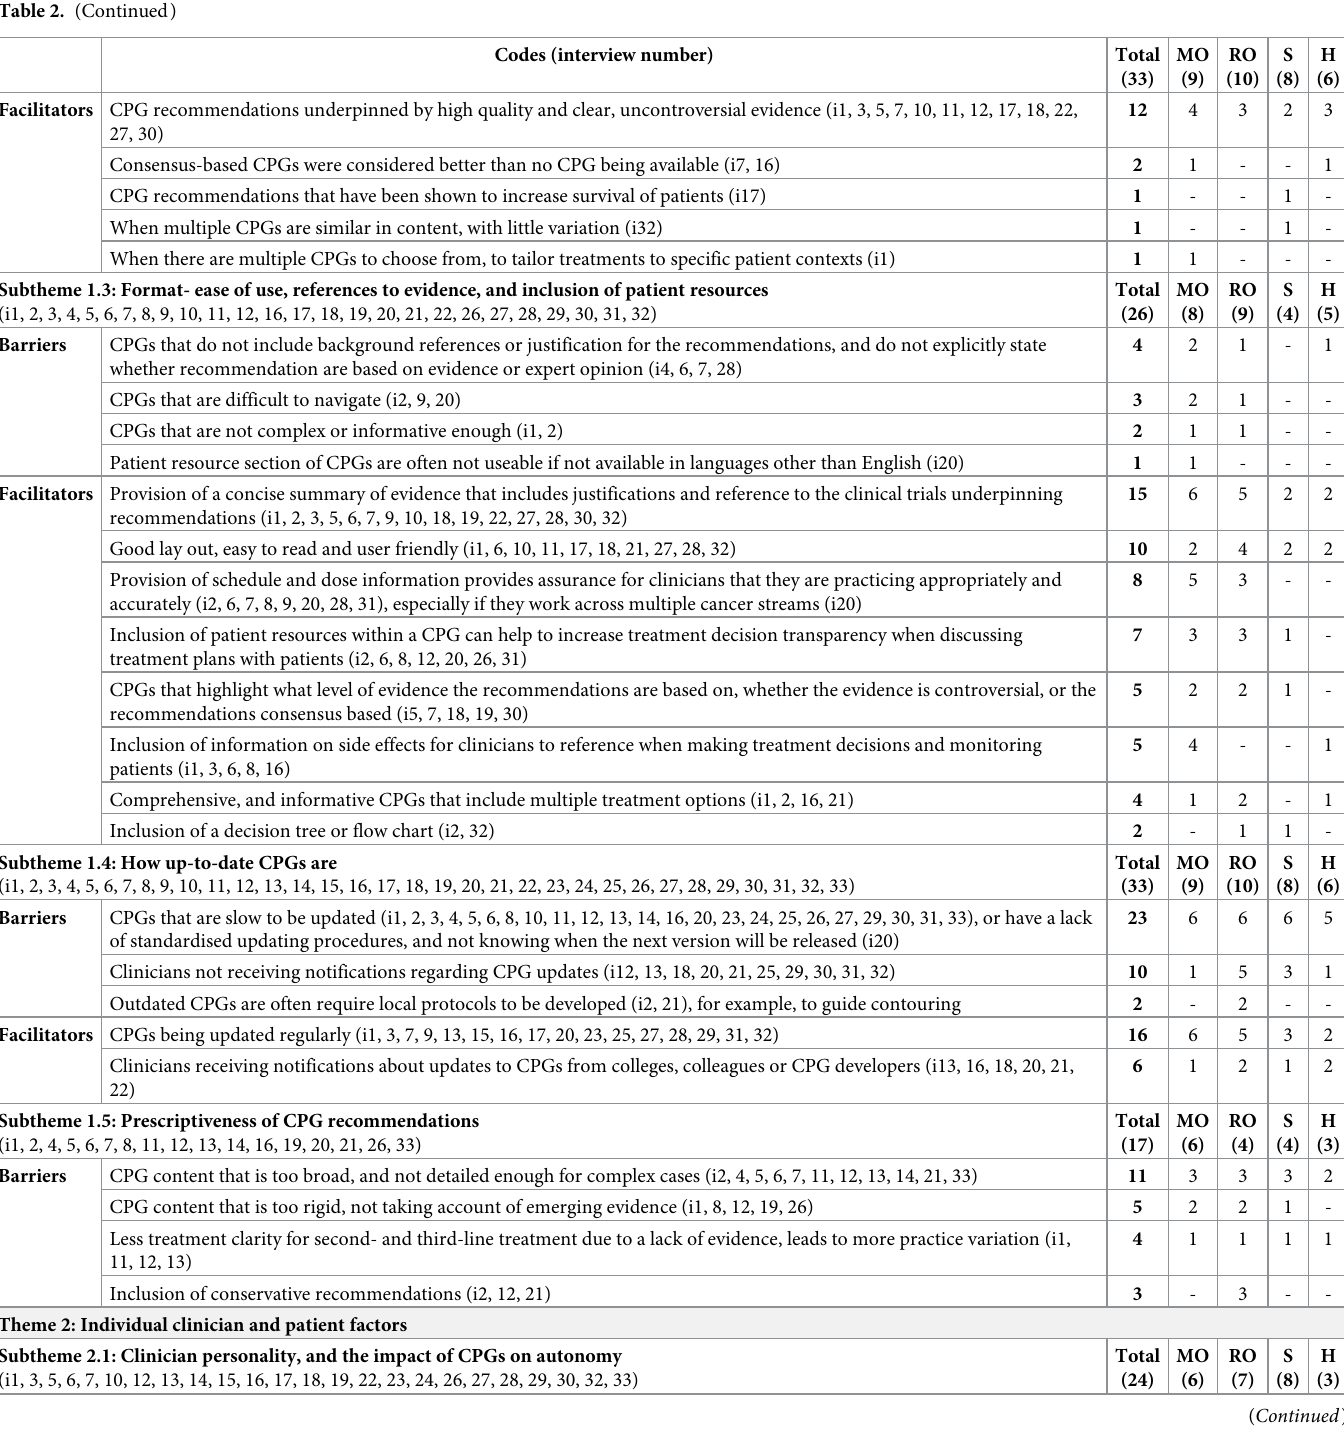
Theme 2: Individual clinician and patient